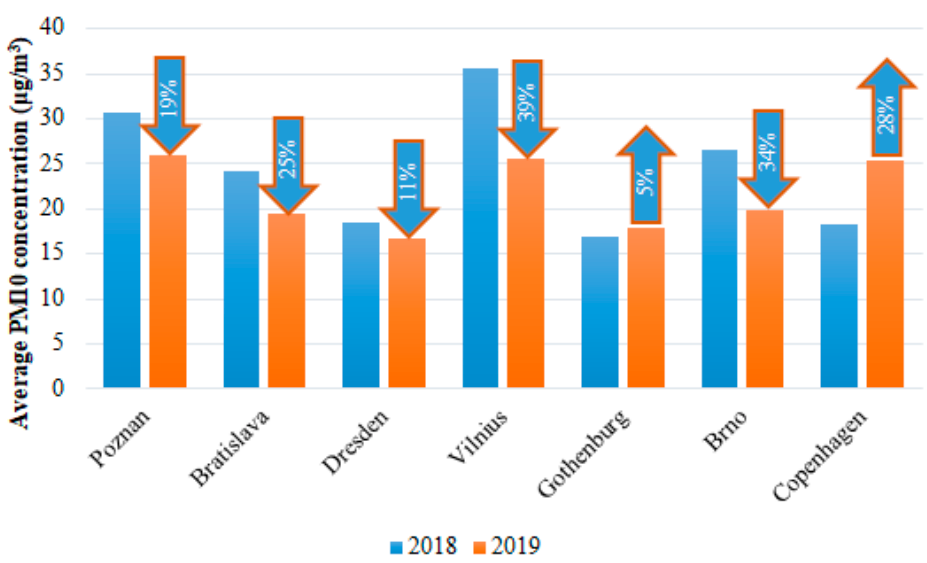
Figure 3. Average PM10 concentration in cities of neighboring countries of Poland in 2018 and 2019, own study based on [13,29].